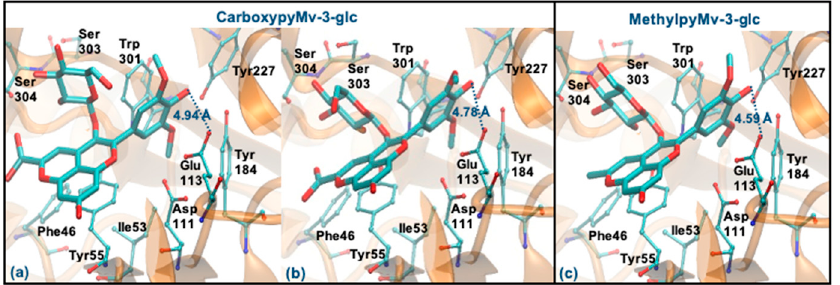
Figure 10. Representation of the structure of hyaluronidase complexed with CarboxypyMv-3-glc (interaction by ring B—( a , b )) and MethylpyMv-3-glc (interaction by ring B—( c )), showing the interacting residues of the active site. The enzyme is depicted in cartoon and colored in orange, the ligands are represented with sticks and colored by atom type, whilst the interacting residues are depicted in ball-and-sticks and colored by atom type. Hydrogen atoms are not represented to simplify the visualization.